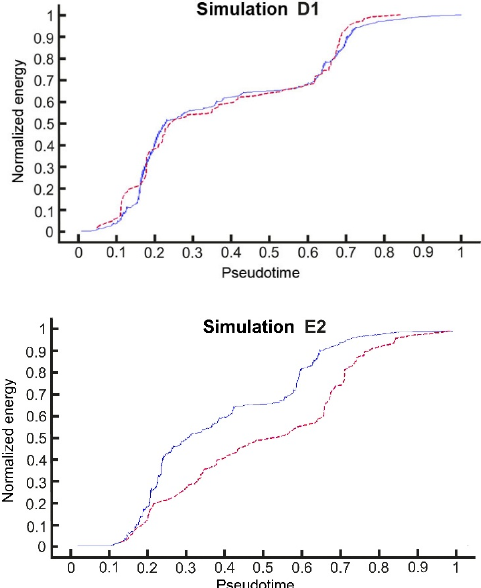
Figure 17. Accumulated AE energy (dashed line) and accumulated plastic strain energy (solid line) obtained for the RC slab. Both were normalized at the end of each